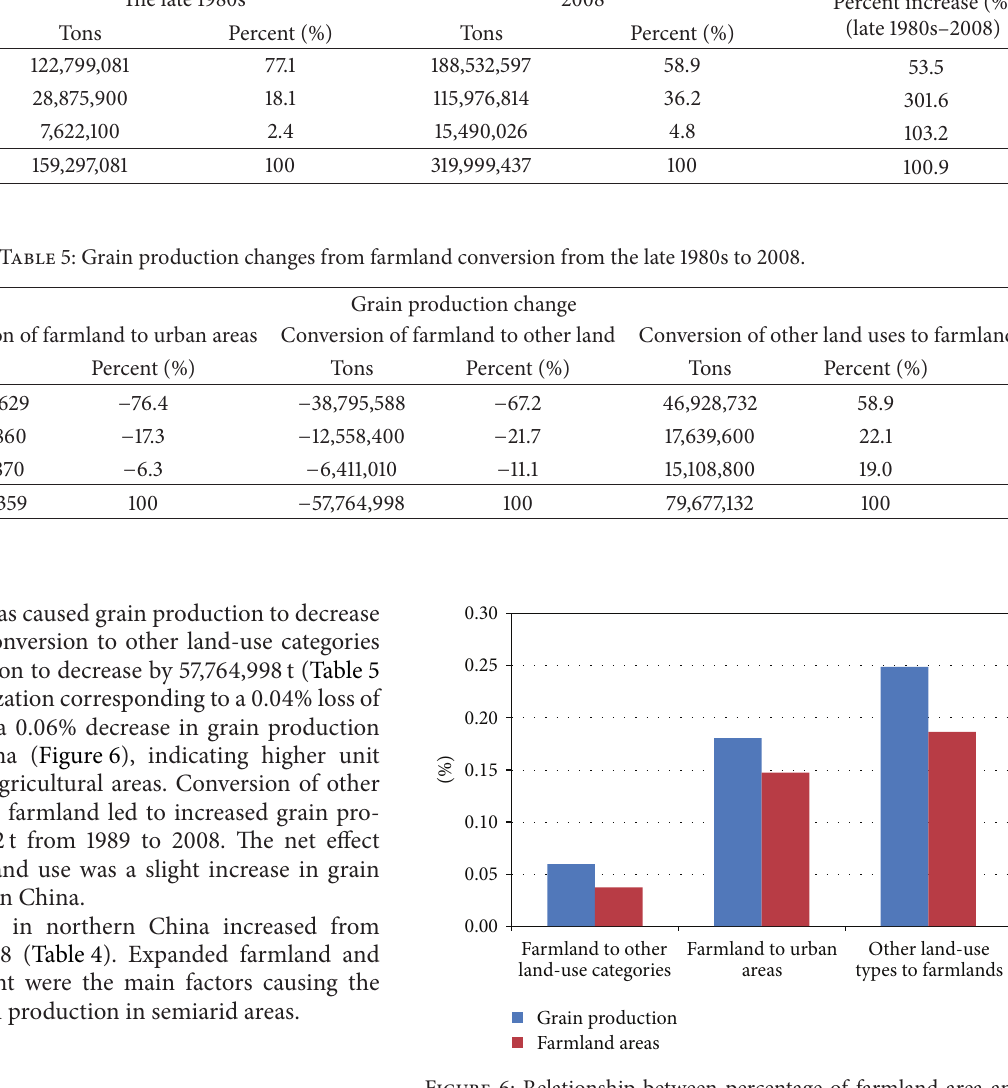
Figure 6: Relationship between percentage of farmland area and grain